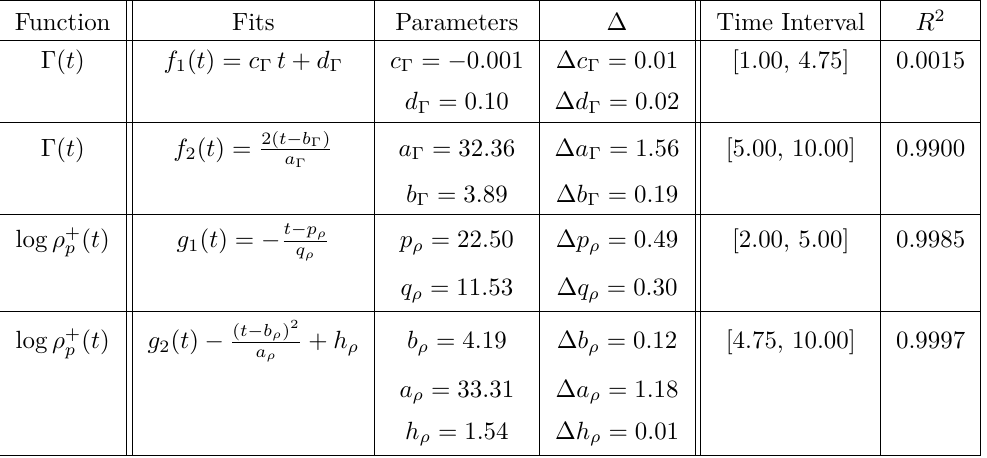
( t ) shown in figure 3. As expected p , a and q 1 /d 10 . ρ ≈ b Γ ρ ≈ a Γ ρ ≈ Γ ≈